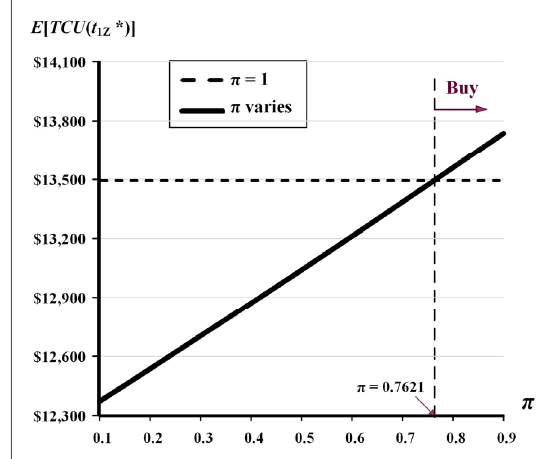
Fig. 16. The impact of variations in ( P 1A / P 1 ) ratio on